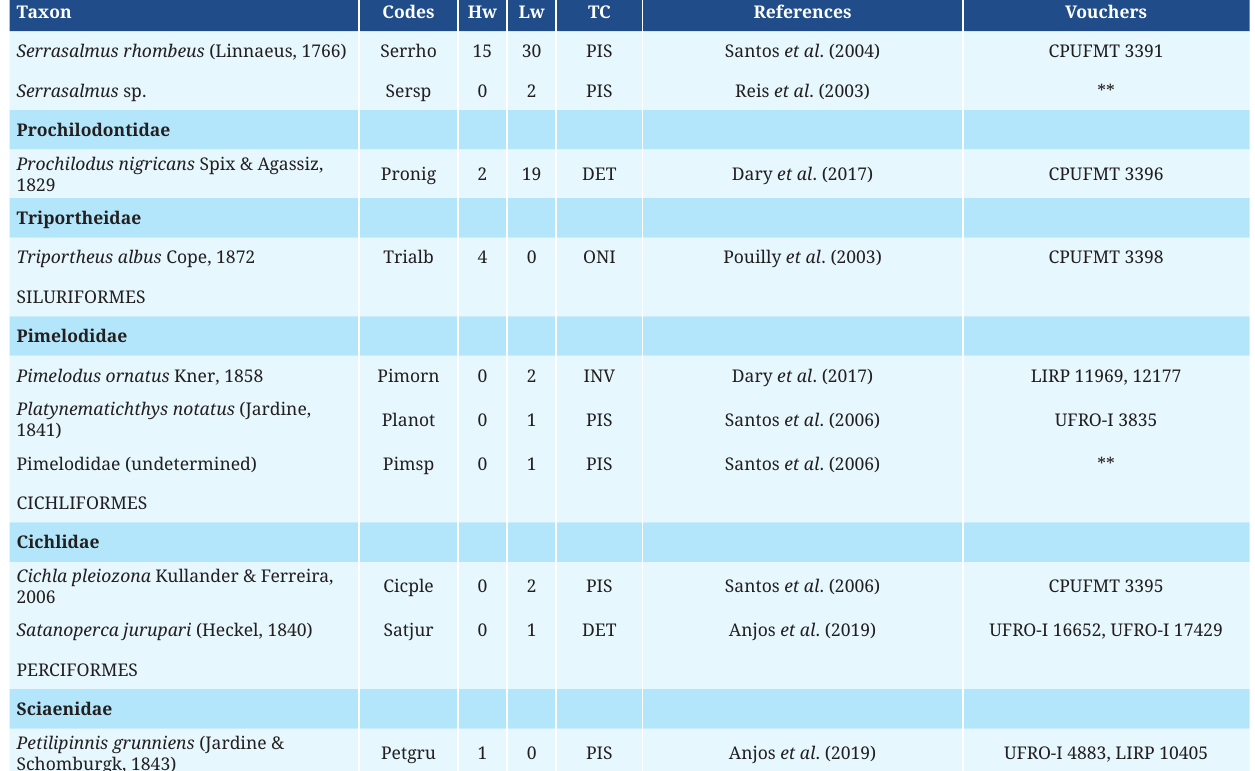
TABLE 3 | Results of SIMPER analysis of the fish assemblage between high (H) and low (L) water seasons. Species Contribution (%)